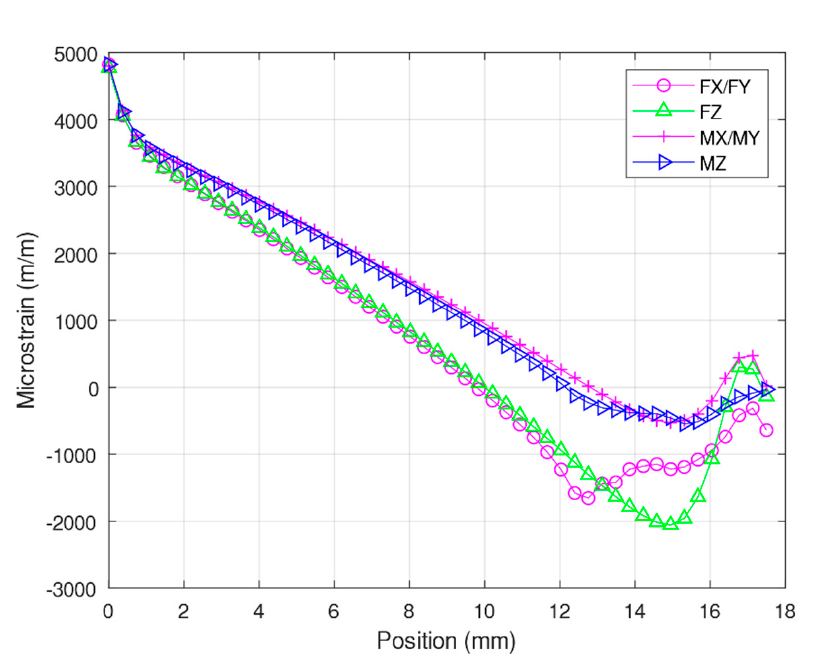
Figure 4. Normal strain on the middle of elastic beam.